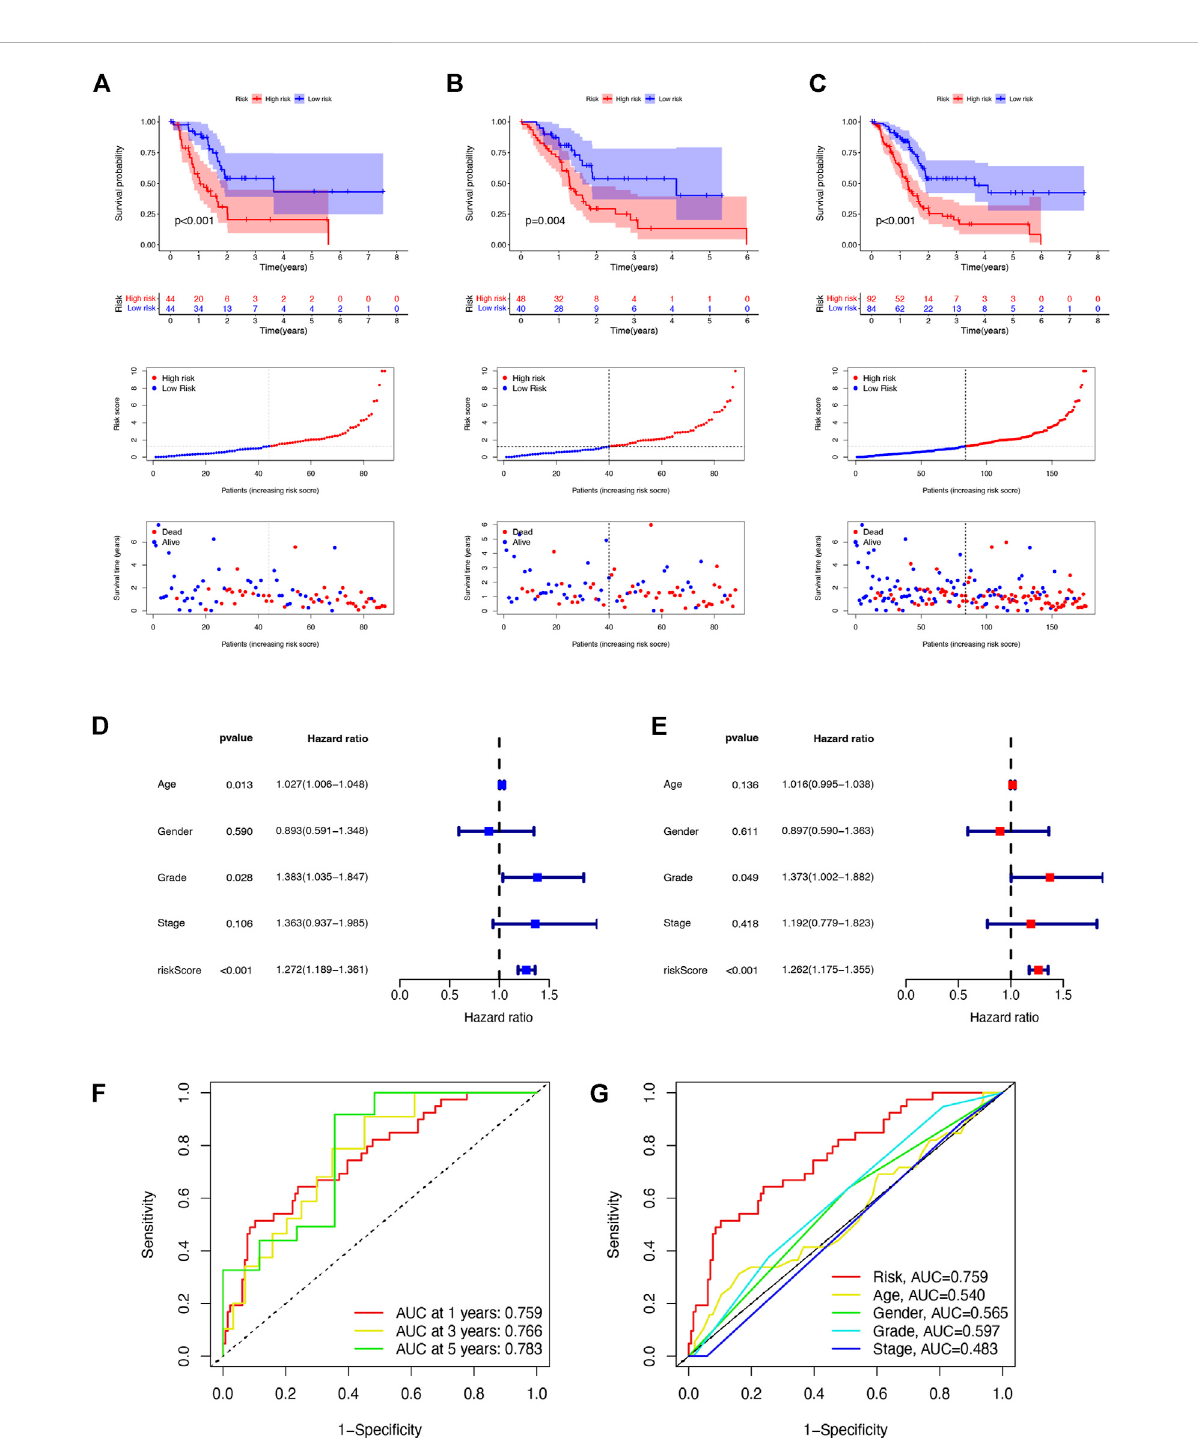
FIGURE 2 Prognosisvalueofthe fi veNRLmodelsinthetrain,test,andentiresets. (A) Riskscoredistribution,scatterplots,andKMsurvivalcurveanalysisof patients with PAAD in the training cohort. (B) Risk score distribution, scatter plots, and KM survival curve analysis of patients with PAAD in the testing cohort. (C) Risk score distribution, scatter plots, and KM survival curve analysis of patients with PAAD in the entire cohort. (D) Univariate Cox regression showing that the age, grade, and risk score were associated with the OS ( p < 0.05). (E) Multivariate Cox regression showing that the riskscore ( p < 0.001)wasanindependentprognosticindicatoroftheOSinpatientswithPAAD. (F) 1-,3-,and5-yearROC curvesoftheentireset. (G) 1-year ROC curves of the risk score and clinical